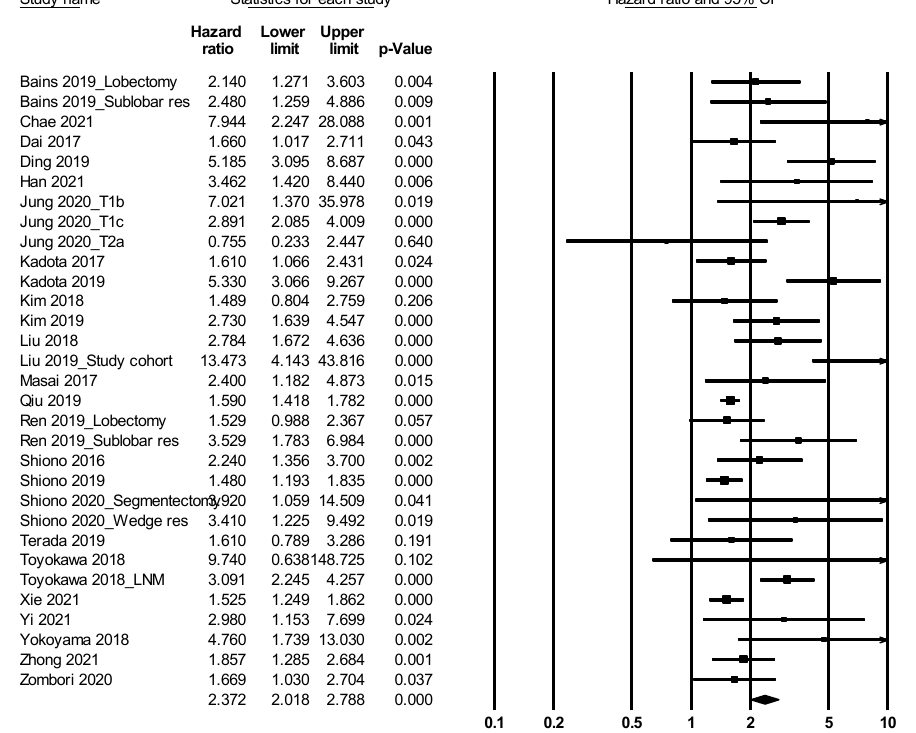
Figure 3. Forest plots for the recurrence-free survival .